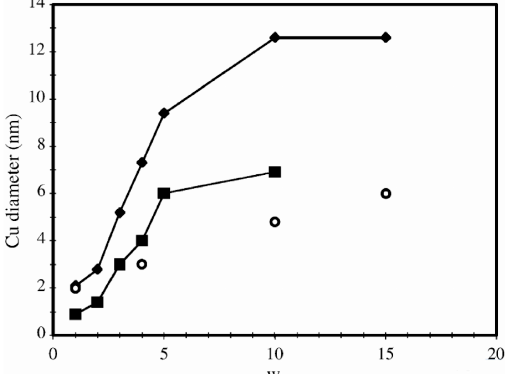
Figure 7. Variation of the mean diameter of copper nanocrystals synthesized in mixed AOT reverse micelles at various water contents w. The solvents are isooctane ( ♦ ) and cyclohexane ( ■ ). This variation can be compared with the diameter of AOT reserve micelles ( ○ ) with the w value (from reference